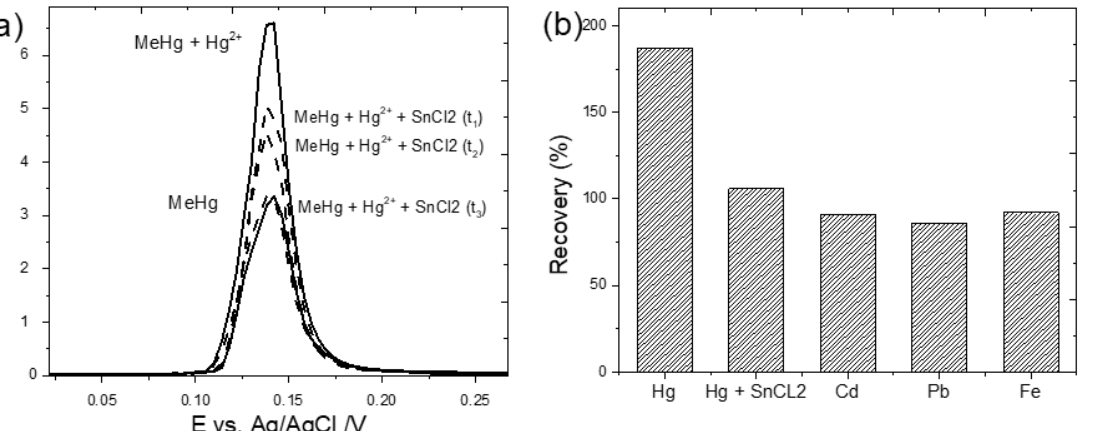
Figure 5. ( a ) DPSV responses obtained for MeHg in the presence of Hg 2+ and SnCl 2 at different times of pretreatment (dash line) and without pretreatment (solid line); ( b ) the effect of other metal ions on the peak current of 600 µg L −1 MeHg based on the application of the CPE/MWCNTs/IIP–MeHg